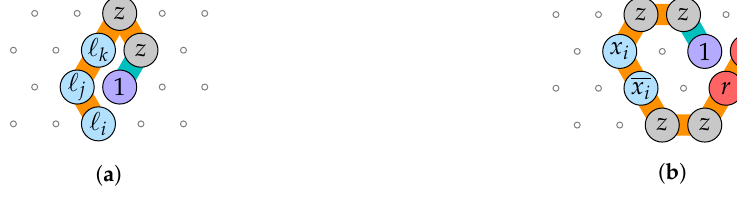
Figure 19. The polynomial-time reduction for 3-SAT to the rule design problem for delay δ “ 1. The seed configurations are linked in orange, and the target configurations are linked in turquoise. ( a ) The seed-target configuration pair for clause (cid:96) i _ (cid:96) j _ (cid:96) k : it is deterministically foldable iff